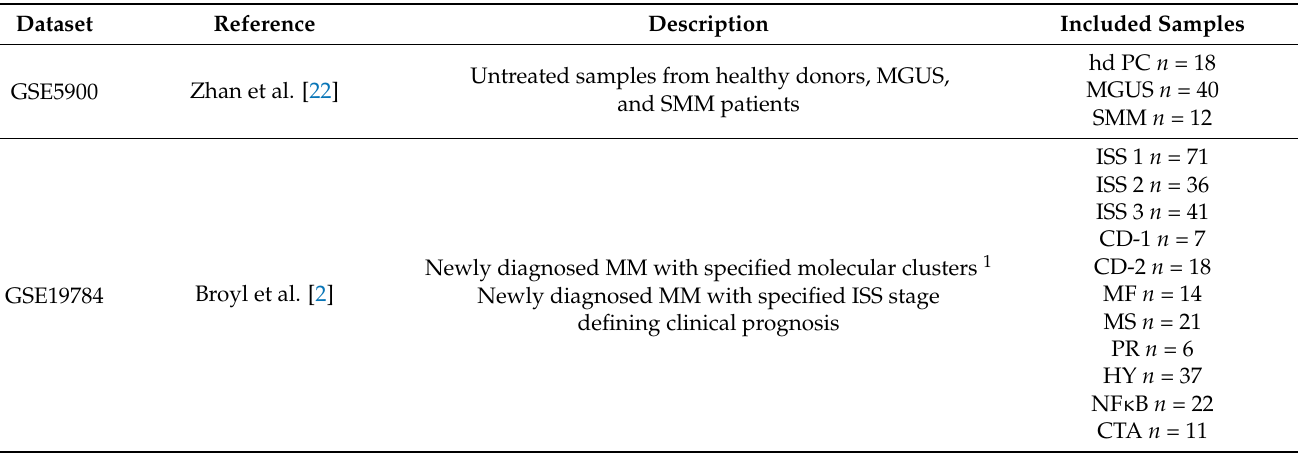
Table 1. Samples included in STA NF κ B analysis per